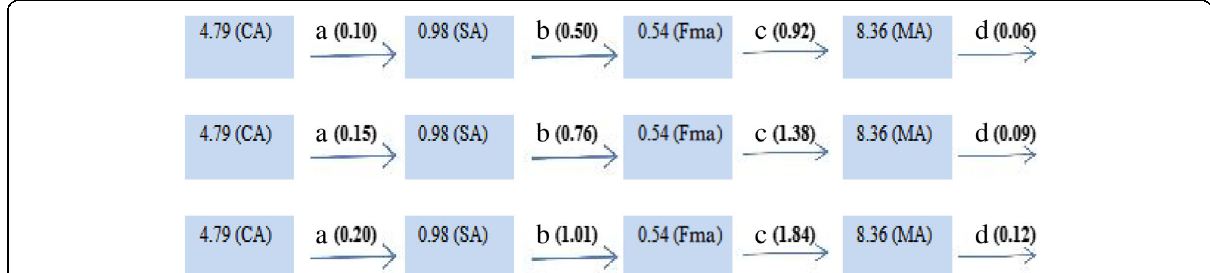
Fig. 5 Rate transfer coefficients (a, b, c) for transformation of citric acid to malic acid (using average leaves concentration) using different rates of utilization of malic acid to other pathways